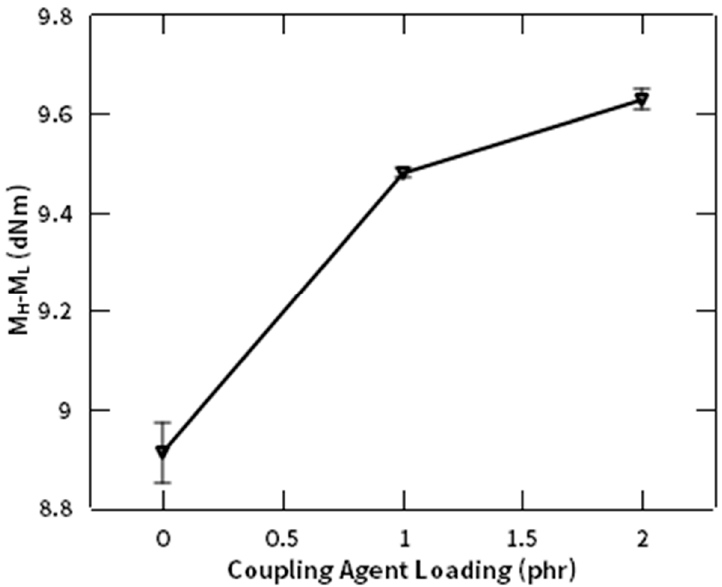
Figure 10. M H -M L profile of NR compound at different composition of NR-g-St.